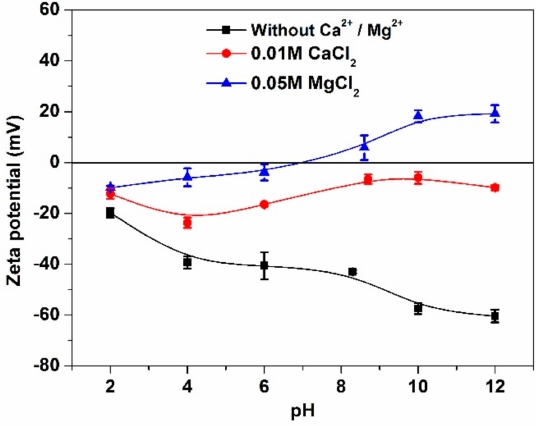
Figure 9. Zeta potential of MoS 2 at different pH valules.